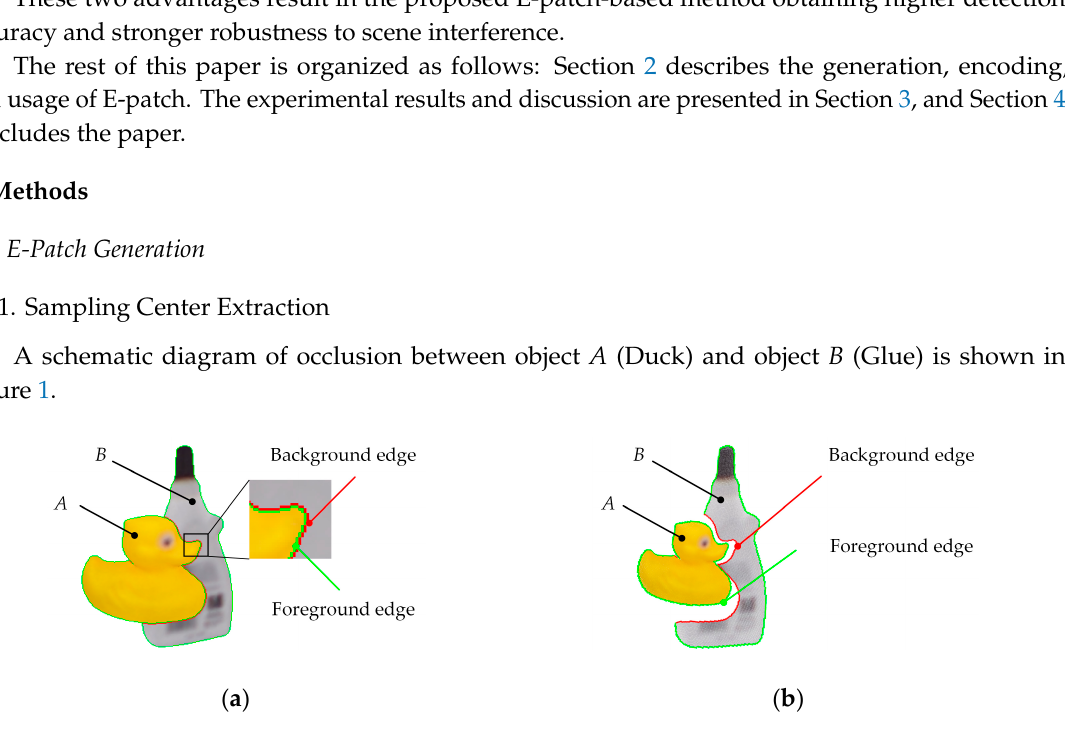
Figure 1. Schematic diagram of foreground edges (colored in green) and background edges (colored in red): ( a ) depth edges marked on the red-green-blue (RGB) image; ( b ) depth edges marked on the point cloud.